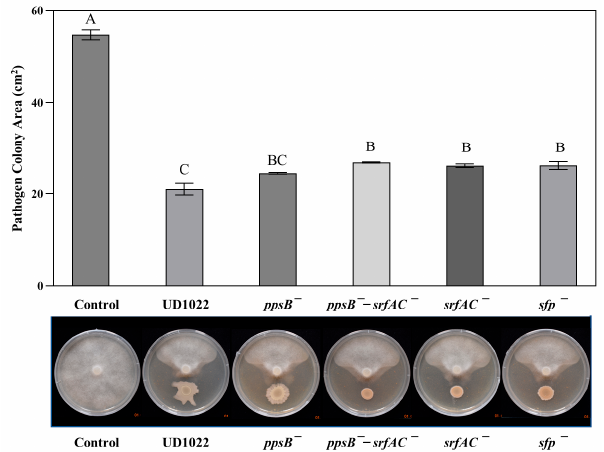
Figure 4. Results of antagonism assays with UD1022 mutants in key nonribosomal peptide (NRP) pathway genes against P. medicaginis A2A1. Bars are the mean colony area ( n = 3) and standard error of the mean (SE) of the mean from one representative experiment of three experiments performed. The colony areas of the NRP mutant treatments, ppsB − - srfAC − , srfAC − , and sfp − were significantly different from the UD1022 treatment ( p = 0.002, 0.006, and 0.006, respectively). The ppsB − treatment colony area was not significantly different from UD1022 ( p = 0.073).